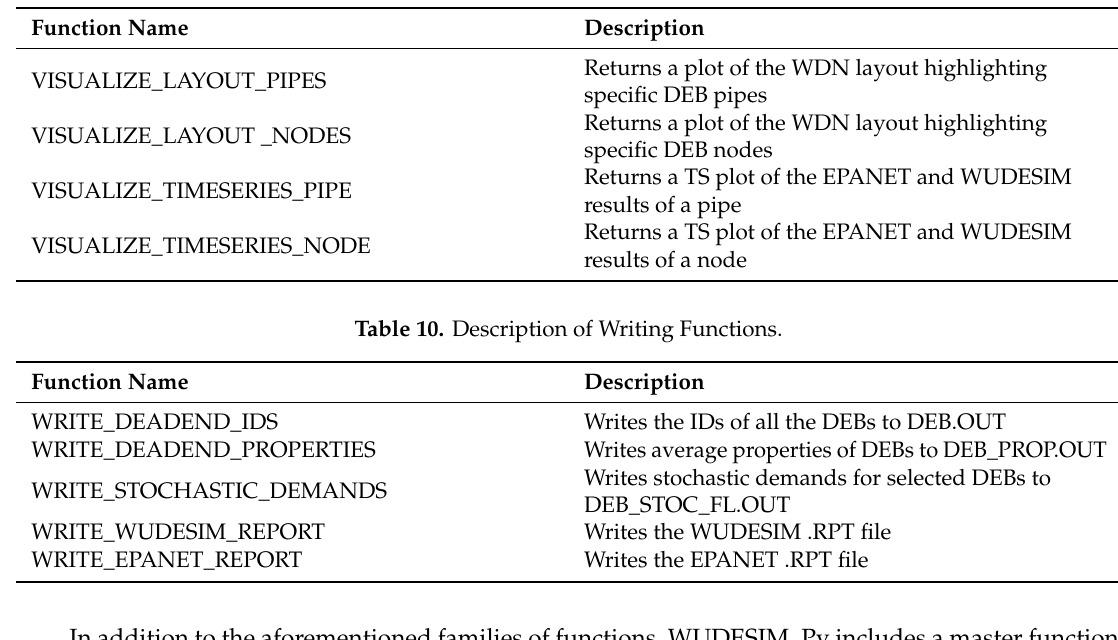
Table 9. Description of Visualization Functions.